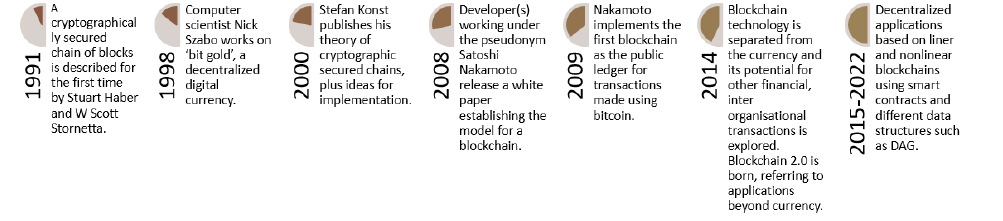
Figure 1. Evolution of blockchain